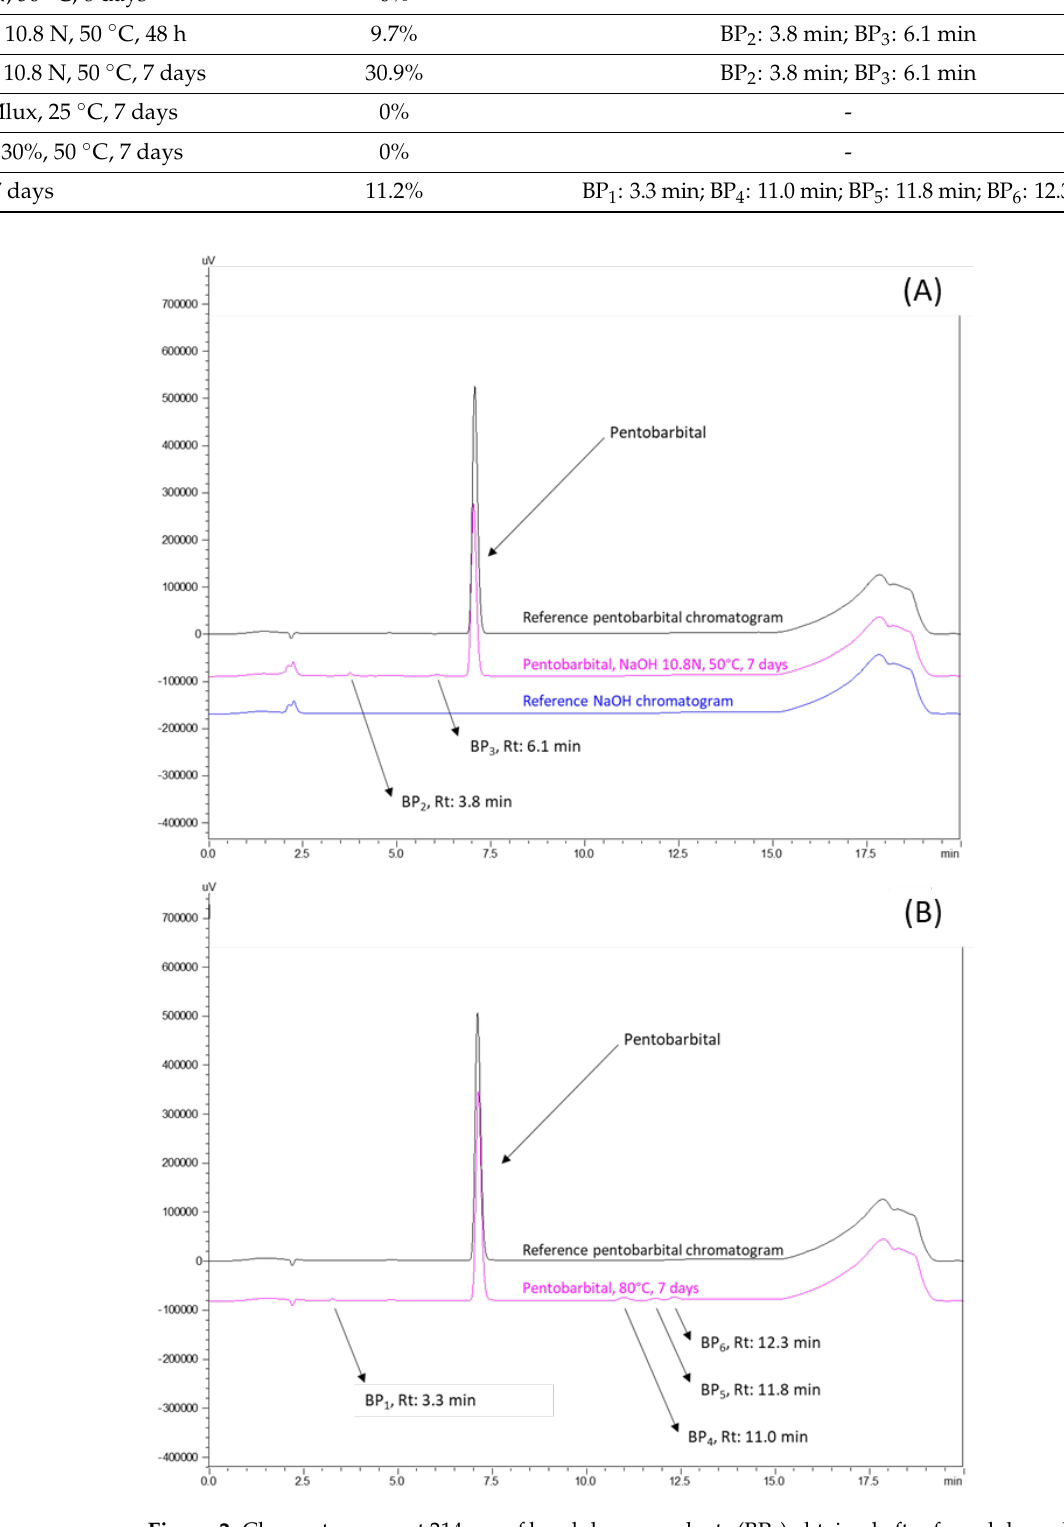
Figure 2. Chromatograms at 214 nm of breakdown products (BPs) obtained after forced degrada- tions: ( A ) alkaline conditions of NaOH 10.8N for 7 days at 50 °C and ( B ) thermic conditions of 80 °C ( A ) alkaline conditions of NaOH 10.8N for 7 days at 50 ◦ C and ( B ) thermic conditions of 80 ◦ C for 7 for 7 days. Rt: retention time. days. Rt: retention